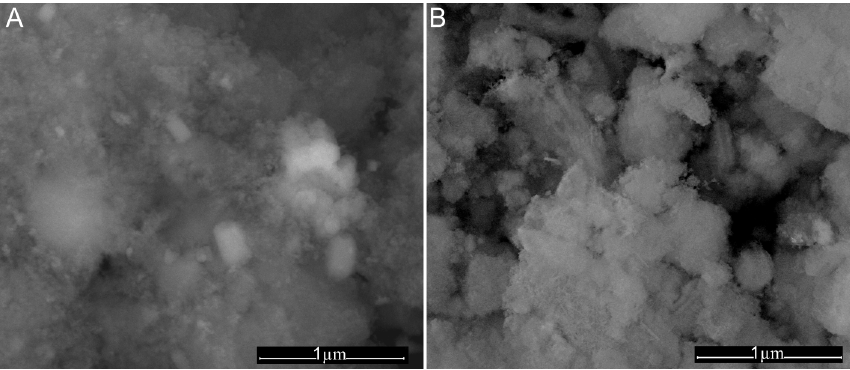
Figure 11. SEM images of: CD-HAp_1 ( A ); and CD-HAp_2 ( B ) samples after the adsorption of Pb 2+ .